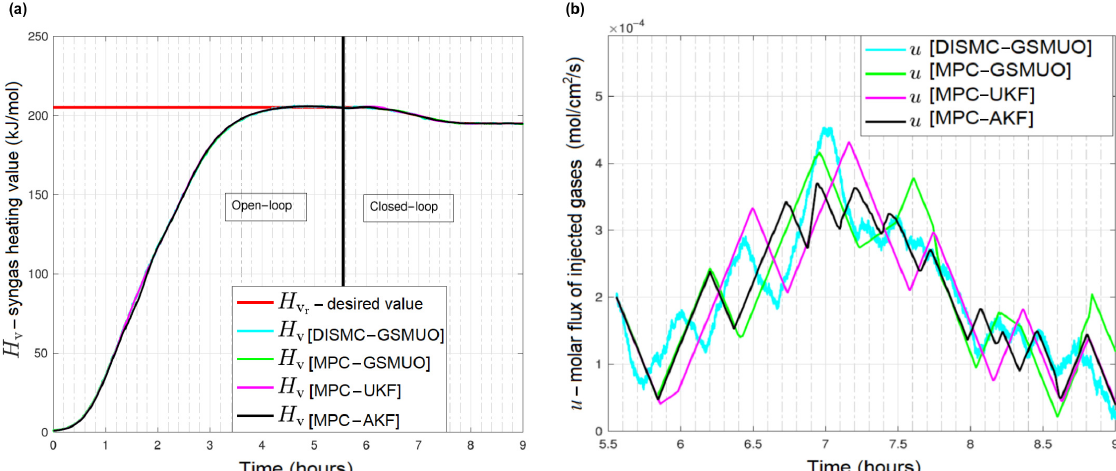
Figure 32. Simulation of MPC: ( a ) syngas tracking by MPC with various state estimators and with sliding mode control, ( b ) behavior of manipulation variable of MPC with various state estimators and with sliding mode control